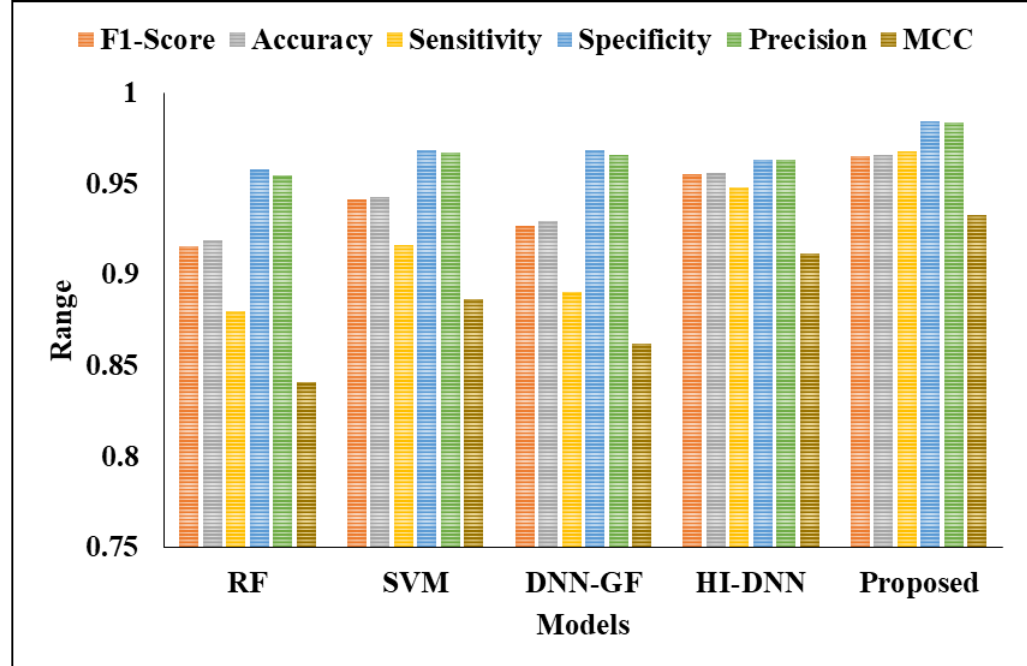
Figure 9. Analysis of the proposed model with existing techniques.